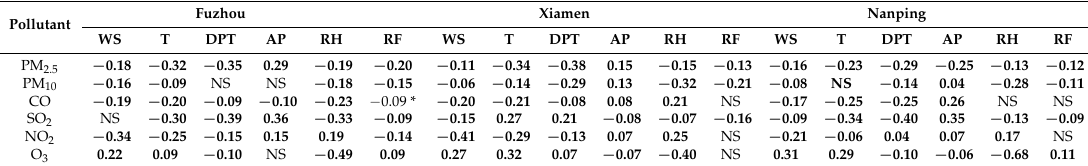
Table 6. Correlations between air pollutants and meteorological factors based on the hourly data during 1 January 2015 to 31 December 2016. Fuzhou Xiamen Pollutant